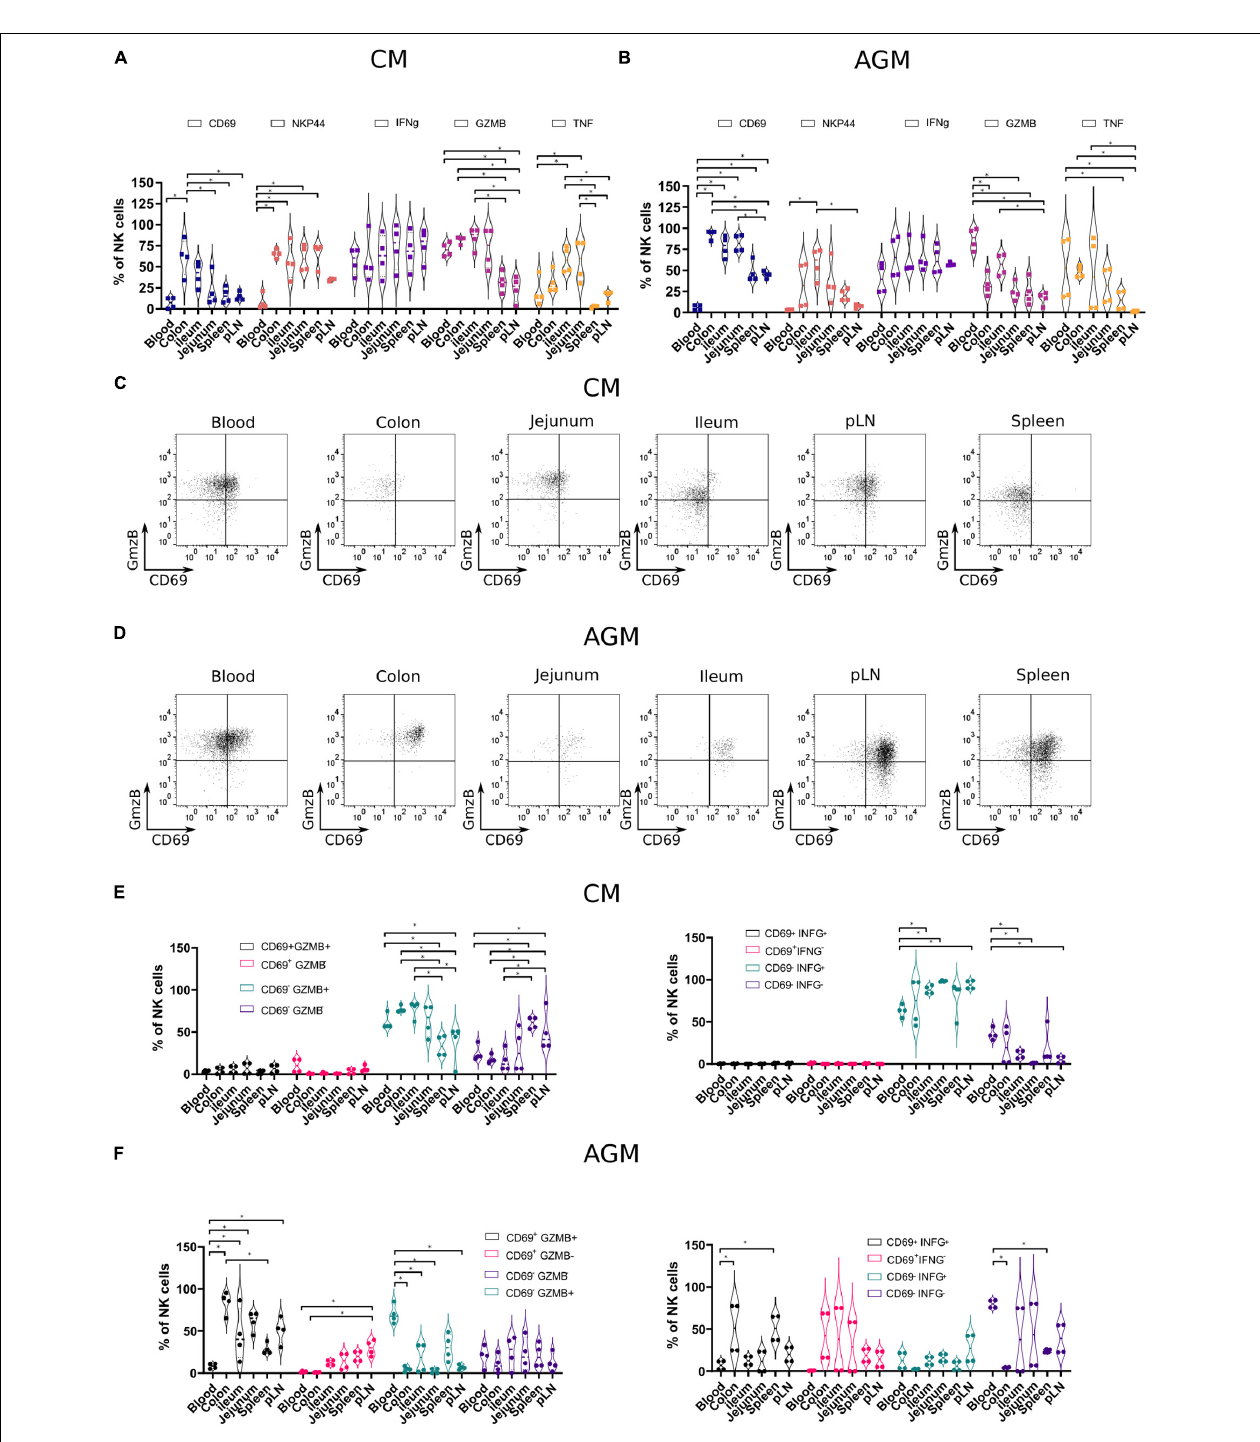
FIGURE 5 | Functional profiles of NK cells in tissues from chronically SIV-infected non-human primates. NK cells from four SIVmac-infected CMs and four SIVagm-infected AGMs were analyzed. (A,B) Vioplots showing the distribution of markers on bulk tissue NK cells. Each marker is labeled with a unique color. All comparisons between NK cells were carried out using a one-way analysis of variance (ANOVA) and followed by a Tukey’s multiple-comparison test. The latter is a post hoc test based on the studentized range distribution. (C,D) Representative dot plots showing NK cells according to CD69 surface expression and intracellular expression of GzmB in different tissues. Dot plots for a randomly chosen animal per species are shown. (E,F) Graphics showing frequencies of NK cells subsets in different tissues according to CD69 and Grzm B expression (left) or CD69 and IFN-g expression (right). All comparisons were carried out using a one-way ANOVA and followed by a Tukey’s multiple-comparison test. The latter is a post hoc test based on the studentized range distribution. Median and standard error bars are shown. Asterisks indicate a p -value < 0.05.